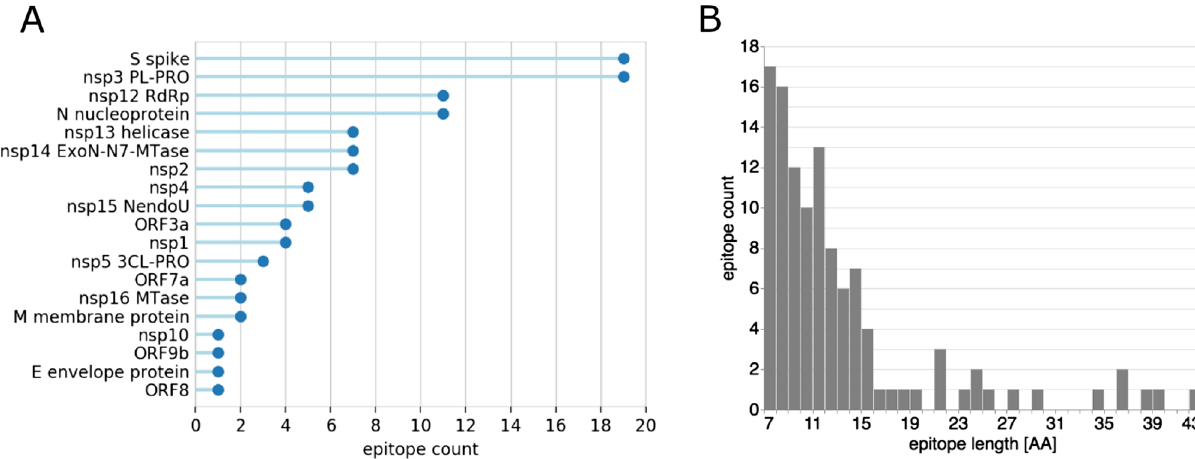
Figure 1. Linear epitope BepiPred2 predictions: ( A ) summary count per protein with at least one predicted epitope; ( B ) length